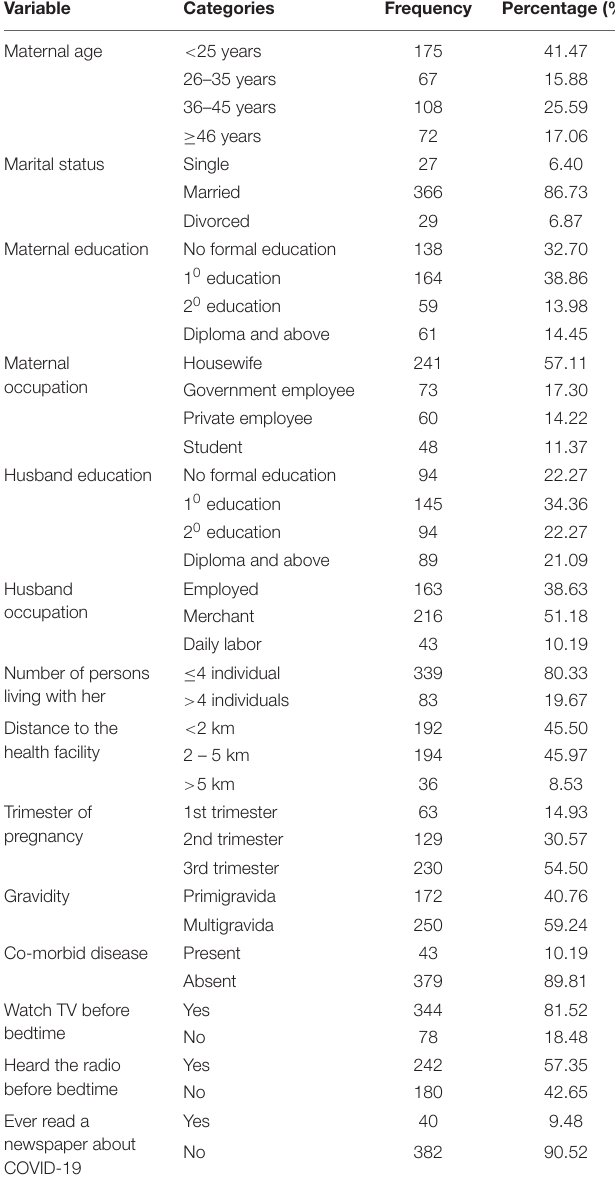
TABLE 1 | The socio-demographic and obstetric-related characteristics of pregnant women attending antenatal care (ANC) services in Debre Berhan ( n =